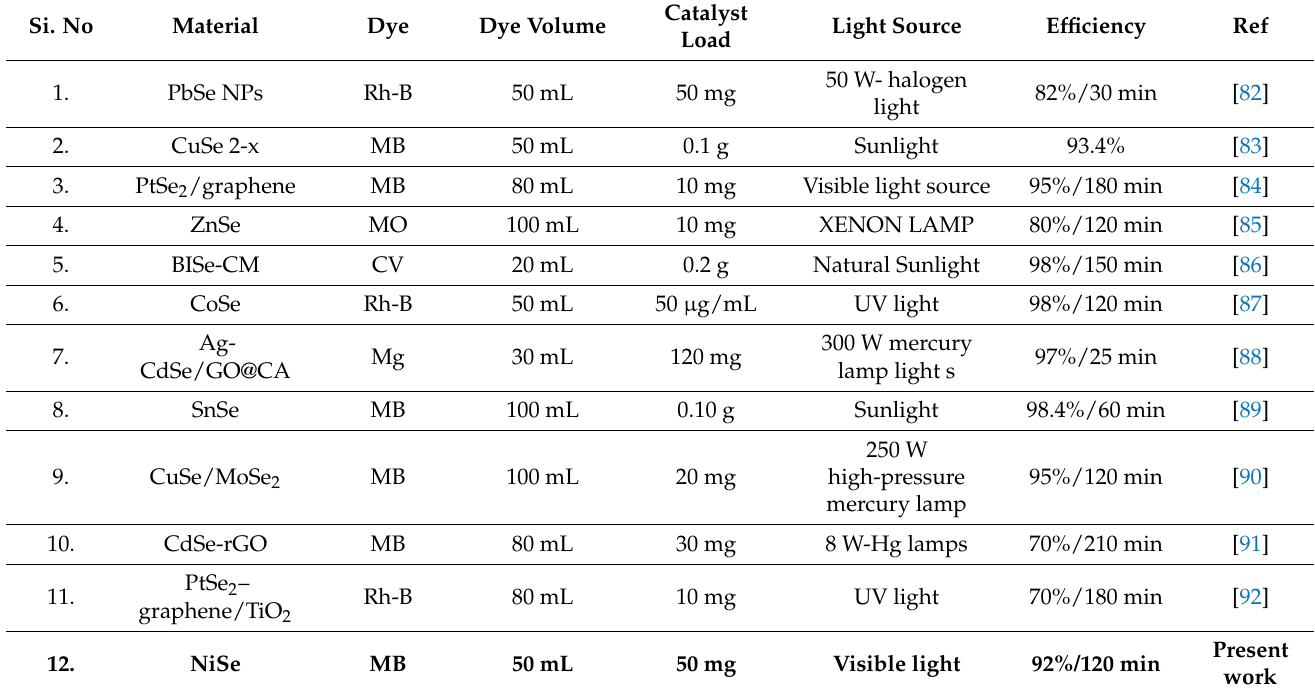
Table 1. Photocatalytic dye degradation comparison table of various